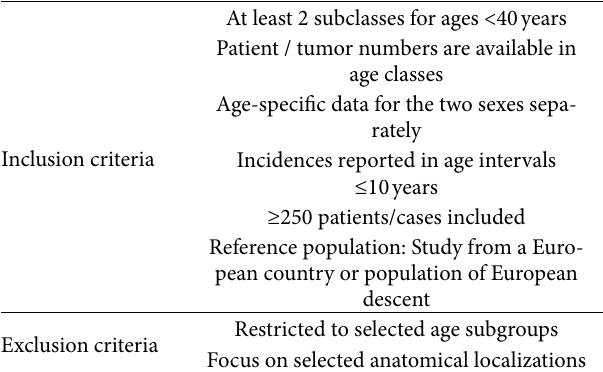
Table 1: Criteria for the selection of data sets.